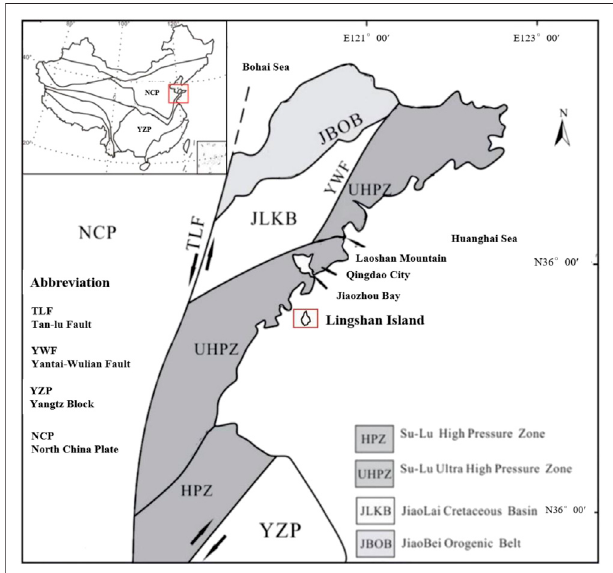
FIGURE 1 | Simpli fi ed map of China showing major blocks and its boundaries and geological map of east Shandong.